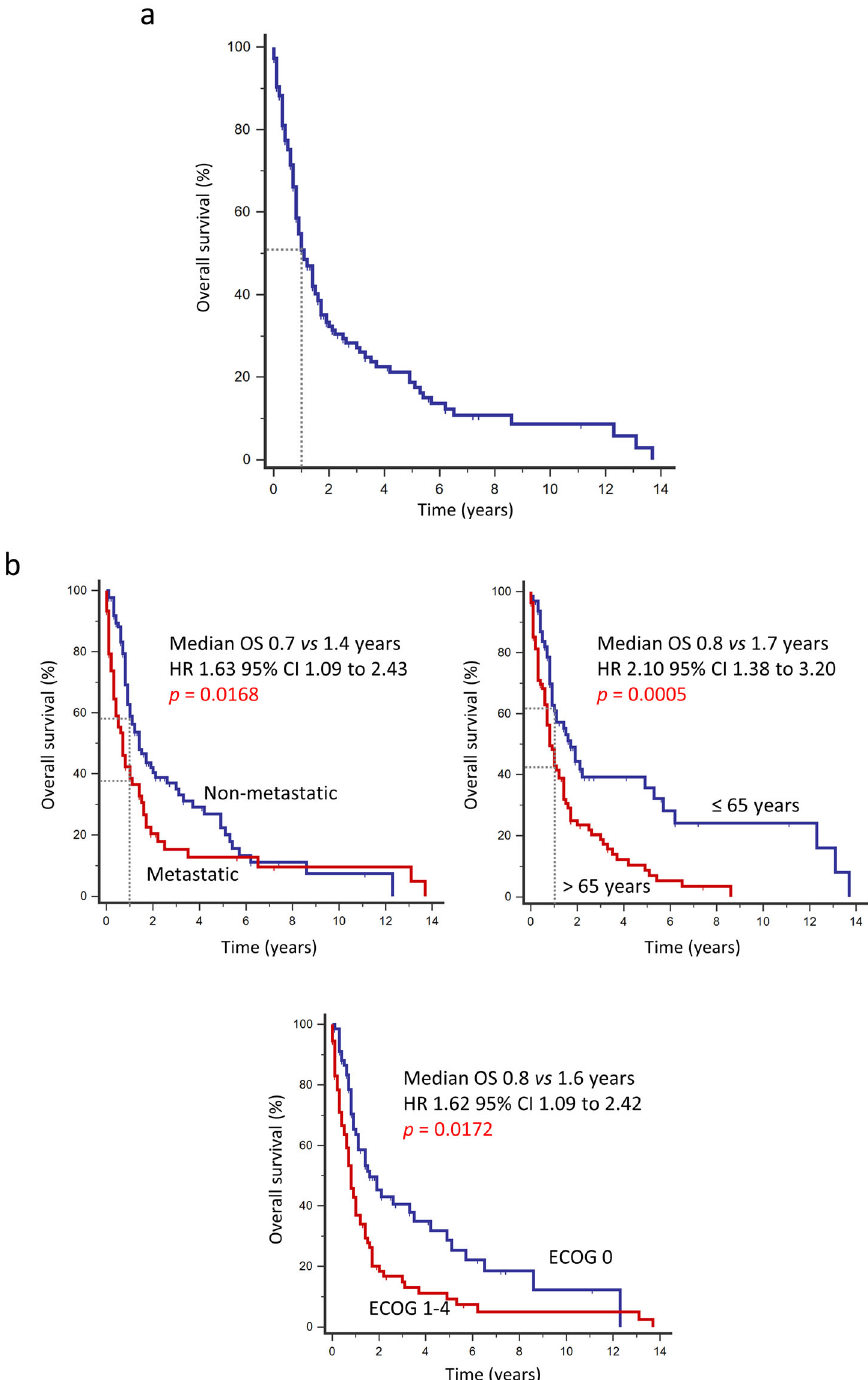
Fig. 1 Overall survival outcomes and prognostic factors in angiosarcoma. a In the overall cohort ( n = 150), 50.8% of the patients were alive at 1 year. Median OS was 1.1 year. b Independent predictors of OS at the time of diagnosis include the presence of distant metastasis, age >65 years, and poor performance status (ECOG 1 –